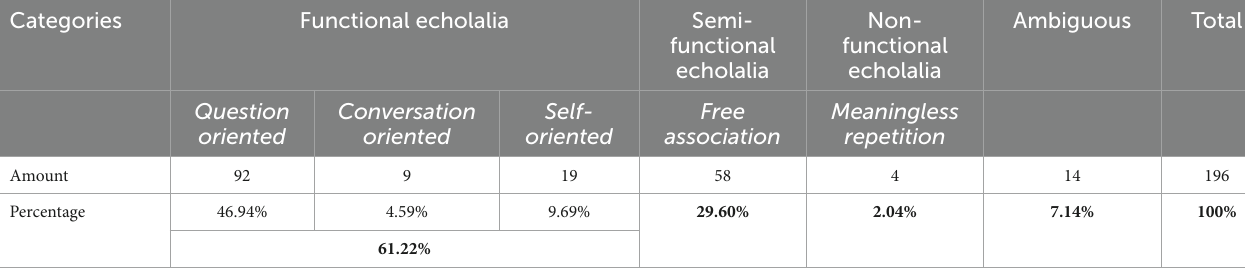
TABLE 6 Functional, semi-functional, and non-functional echolalia.